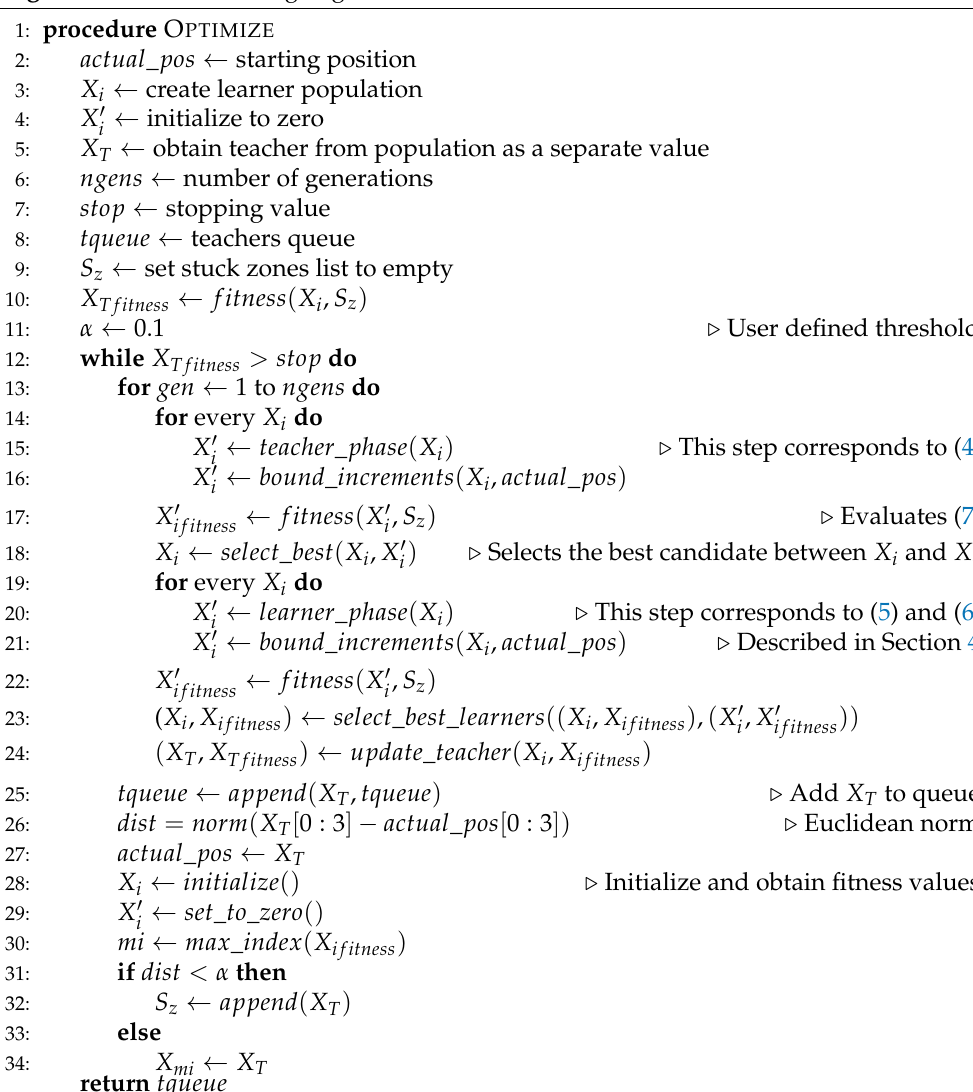
Algorithm 1 Path Planning